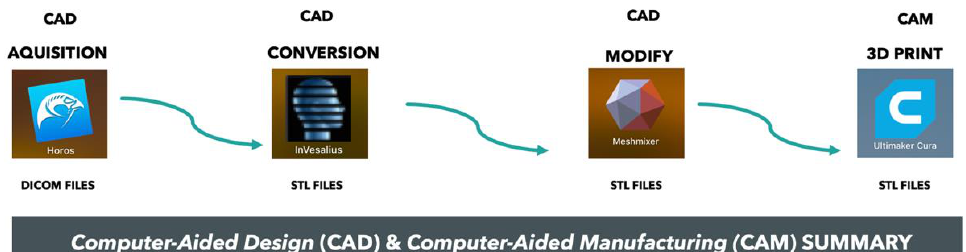
Figure 2. Digital workflow of our study showing in detail every application necessary for the 3D print process (every application is completely open